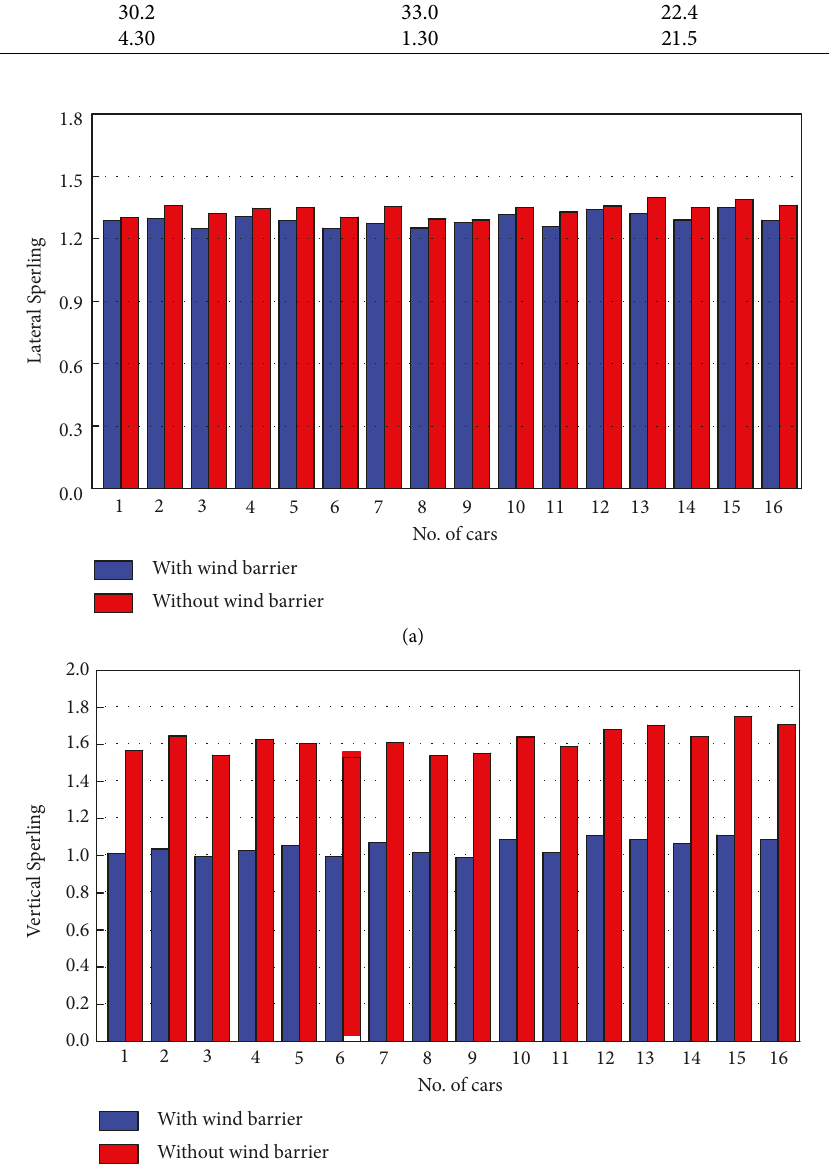
Figure 13: Running stability indices of vehicles with/without wind barrier. (a) Lateral Sperling. (b) Vertical Sperling.